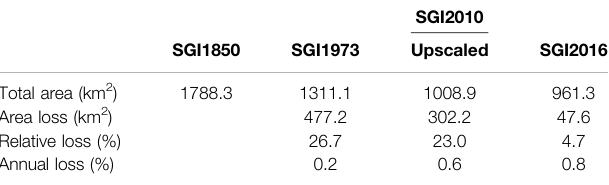
TABLE 6 | Absolute and relative area loss over time according to the SGI ’ s.